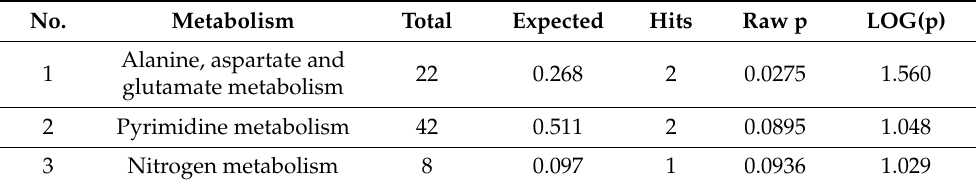
Figure 5. Metabolic pathway analysis of field Soil (contaminated soil). 1: Alanine, aspartate and glutamate metabolism, 2: Pyrimidine metabolism. 3: Nitrogen metabolism. Table 3. Metabolic pathway analysis of field Soil (contaminated